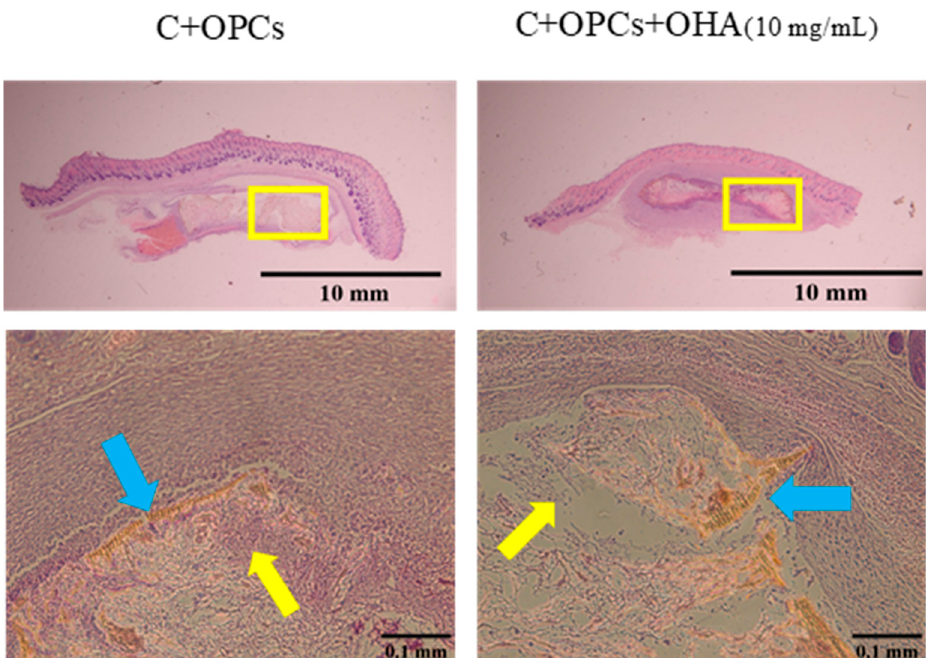
Figure 14. Histological images of collagen + OPC and collagen + OPC + OHA scaffolds implanted under the skull skin were captured after 1 week (upper panel). Enlarged images of areas within the yellow squares of the upper panels are shown in the lower panels (yellow arrows indicate new blood vessel formation, and the blue arrows indicate the scaffolds).